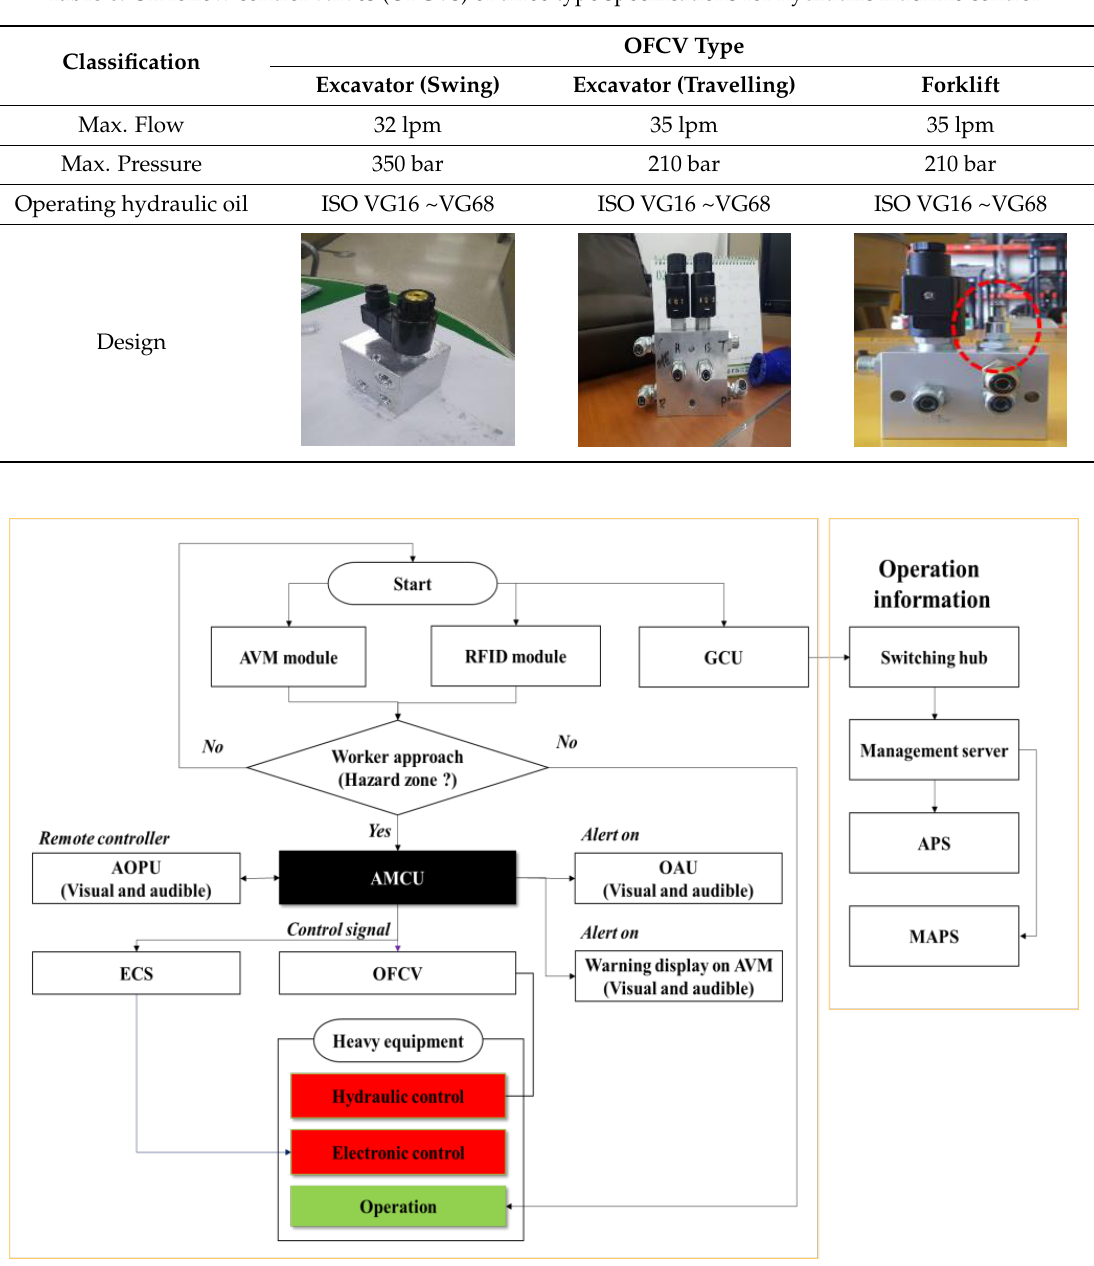
Figure 9. Operational scenario of ACAS and GRMS.